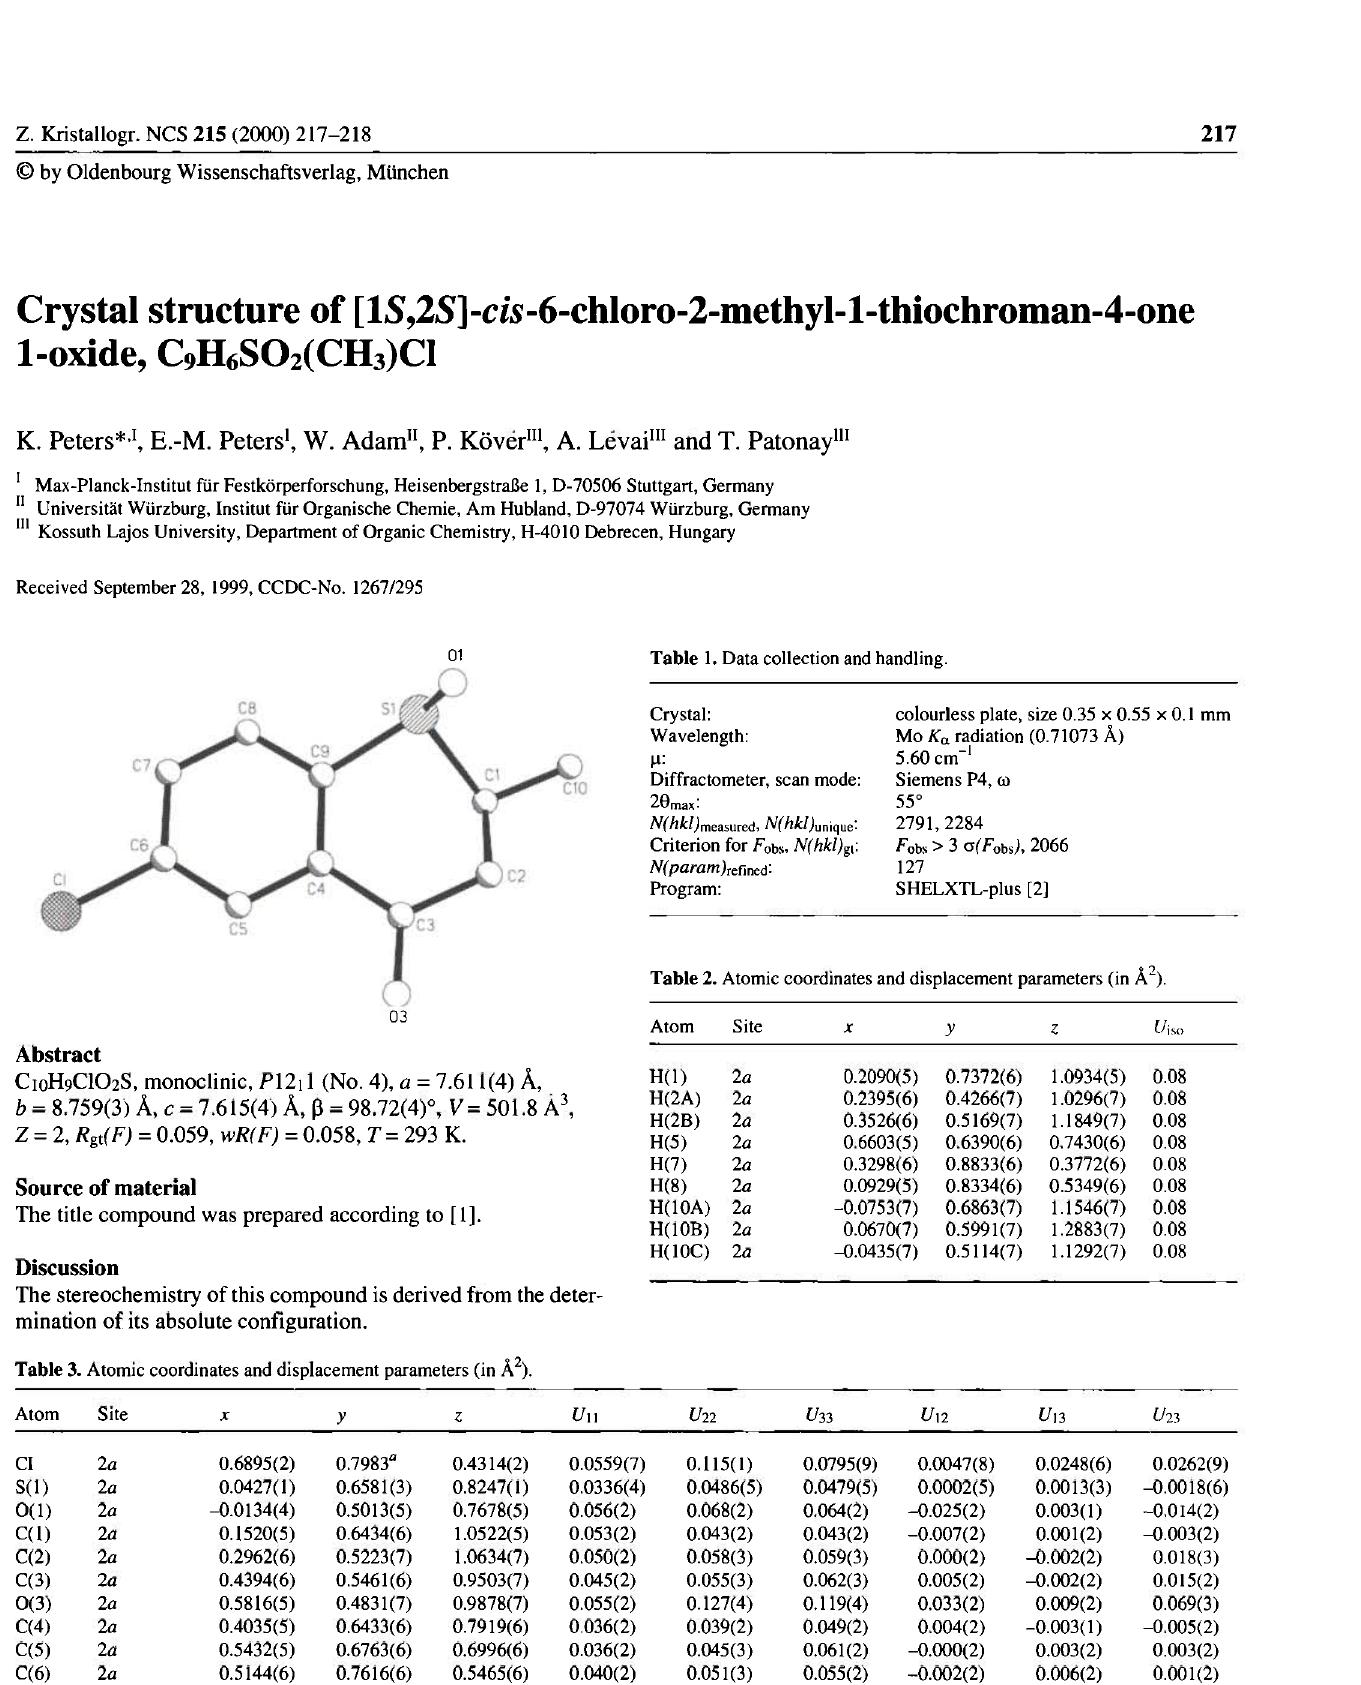
Table 3. Atomic coordinates and displacement parameters (in Ä 2 ).